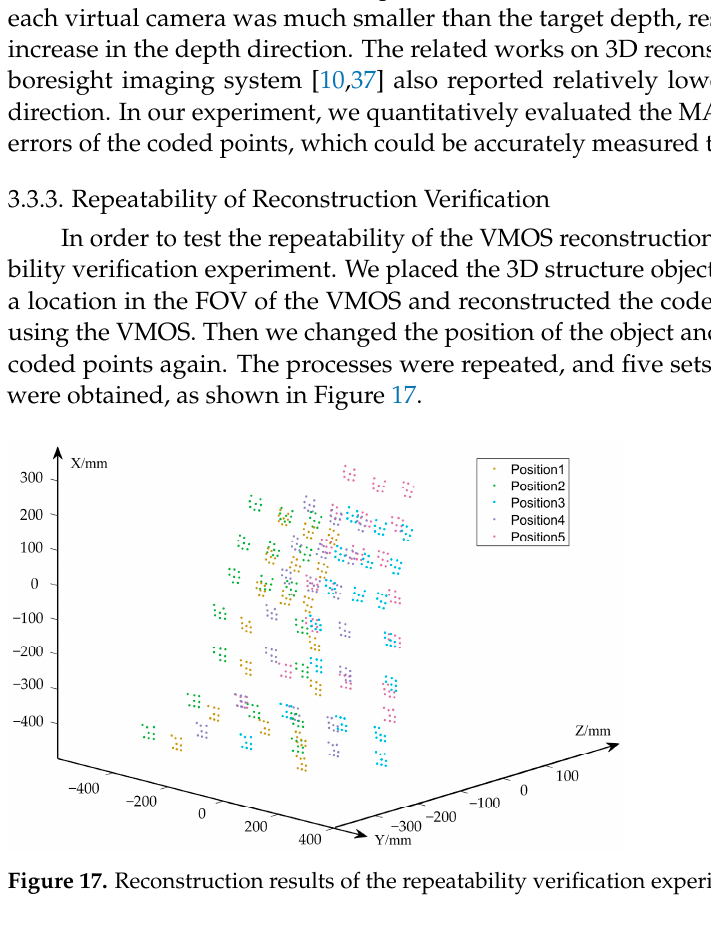
Figure 17. Reconstruction results of the repeatability veri fi cation experiment. Table 5. Distance errors in each pair of aligned sets of points.